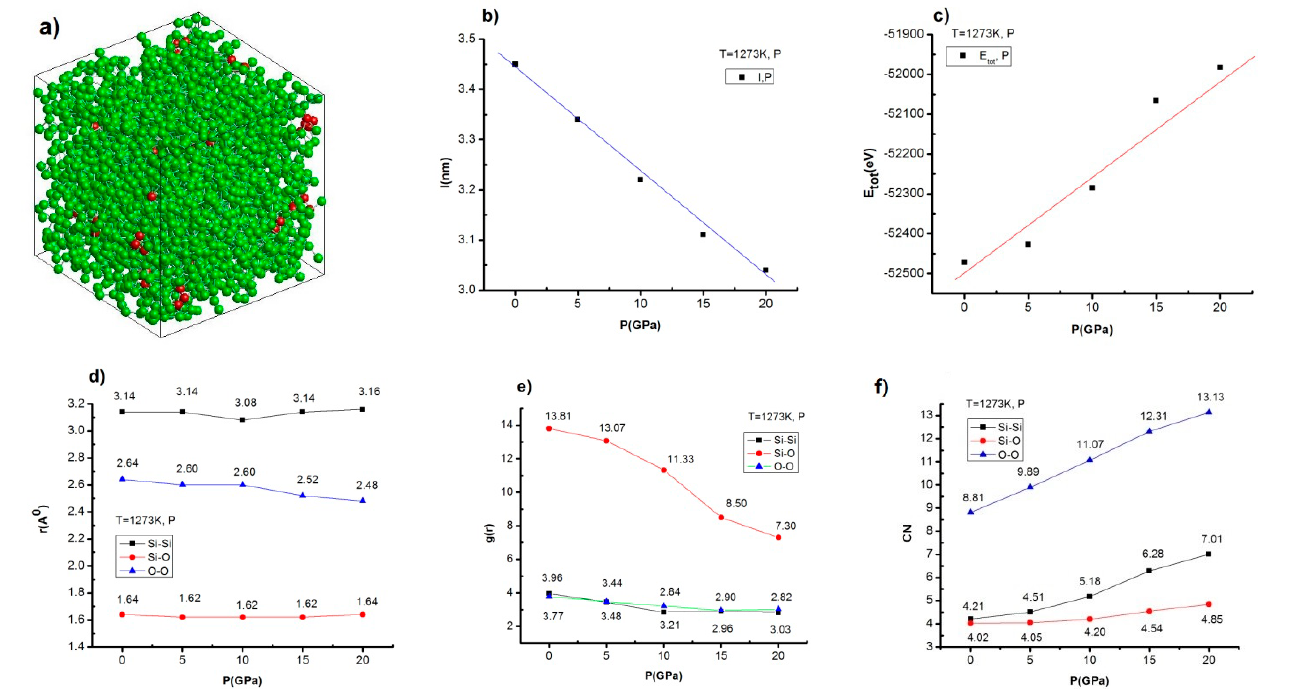
Figure 3. Shape ( a ), l ( b ), Etot ( c ), r ( d ), g(r) ( e ), coordinate number ( f ) of bulk SiO2 at T = 1273 K with different values of p .